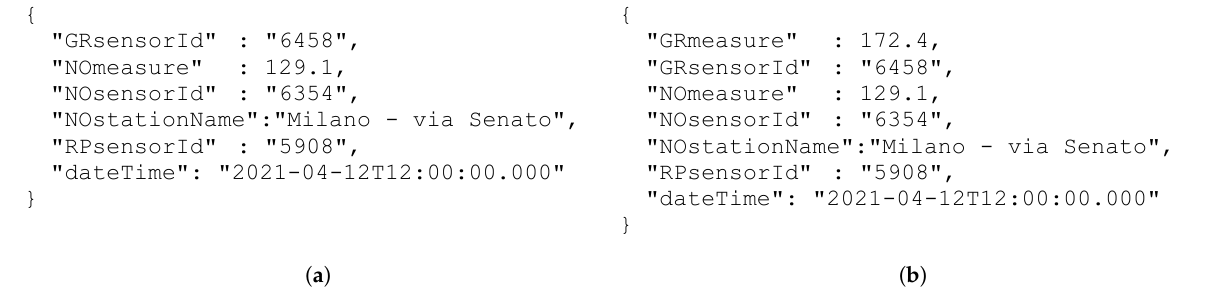
Figure 11. Example of temporary collection generated after line 24 ( a ) and line 26 ( b ). ( a ) Example of a document describing a virtual sensor station extended with the measurement of nitric oxide . ( b ) Example of a document describing a virtual sensor station extended with the measurements of and solar radiation .